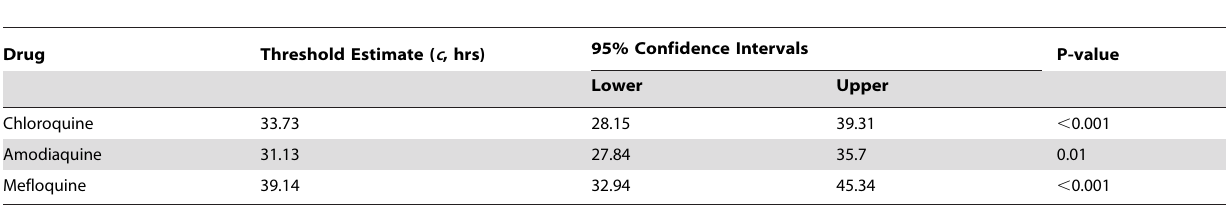
Table 3. Comparison of the threshold points for amodiaquine, chloroquine and mefloquine, when analysing the relationship between assay duration and EC 50 in P. vivax